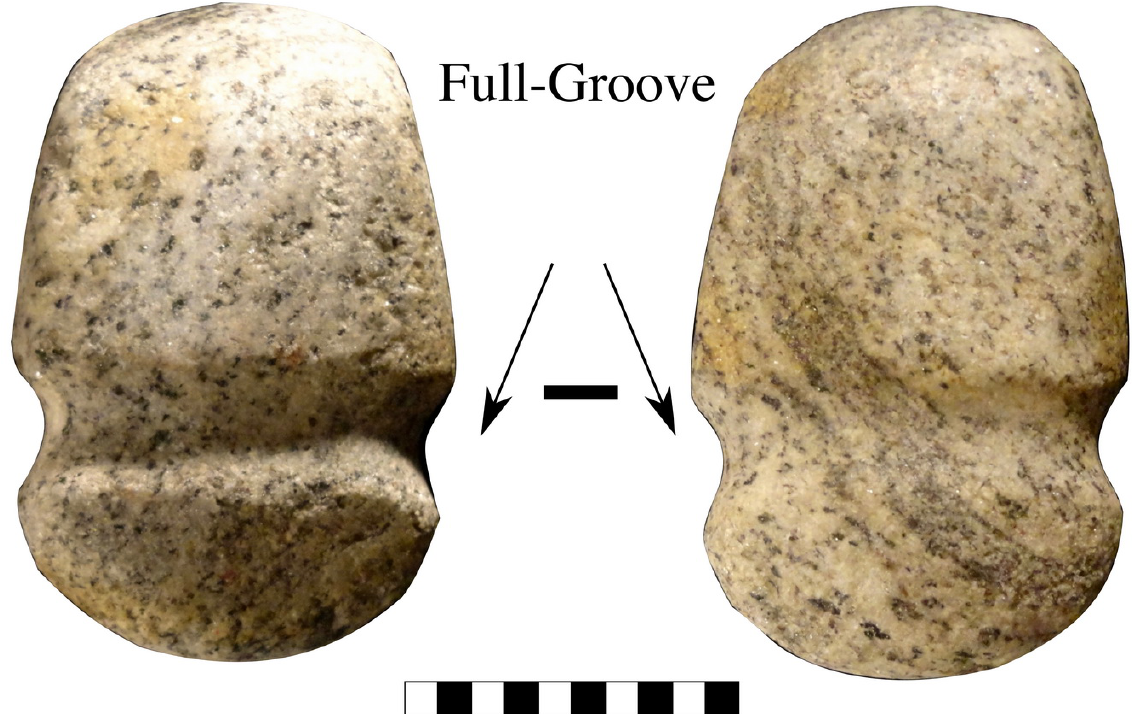
Figure 1. Obverse (L) and reverse (R) surfaces of the full-grooved axe replica. Scale bar = 10